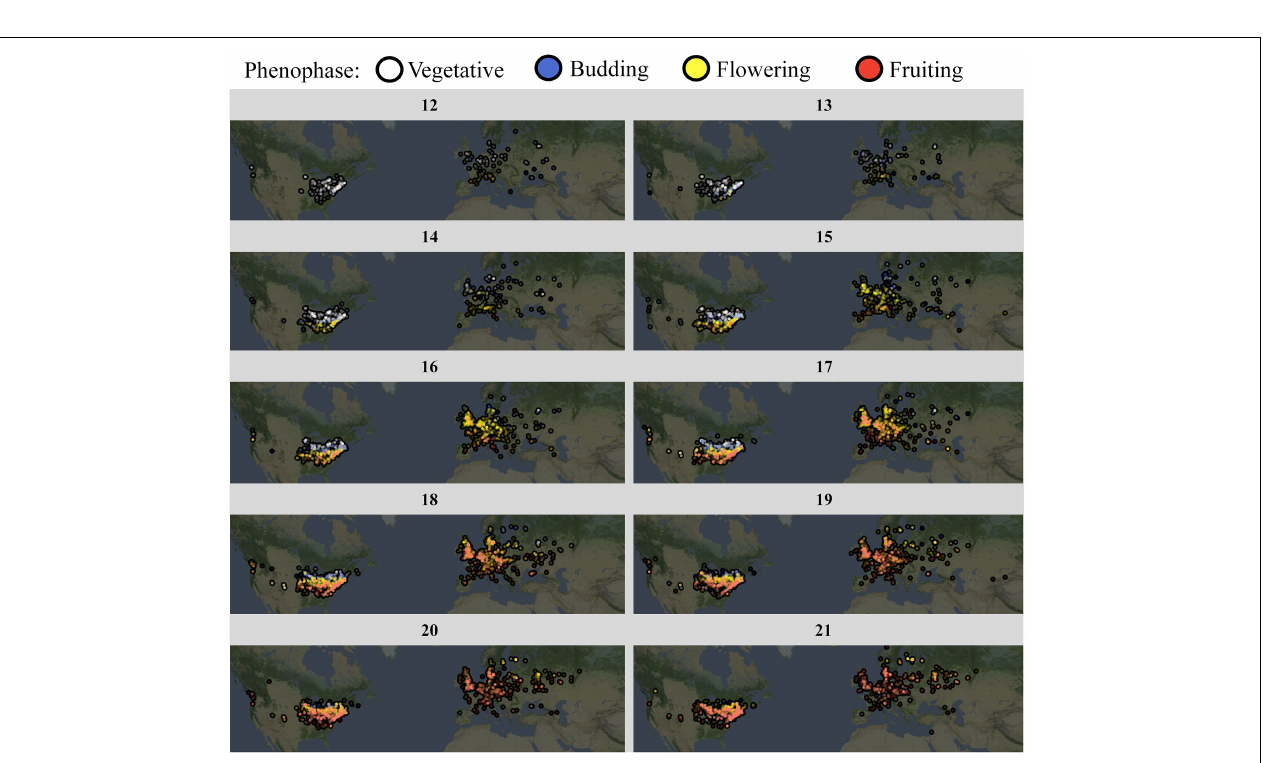
FIGURE 4 | A. petiolata phenology progression, by calendar week. Weekly maps depict A. petiolata phenology using the full, CNN-annotated iNaturalist image set. Date ranges from early March (week 12) to mid-may (week 21). Observations have been combined across years (1995–2020). Color depicts phenophase: vegetative observations are white, budding observations are blue, flowering observations are yellow, and fruiting observations are red.